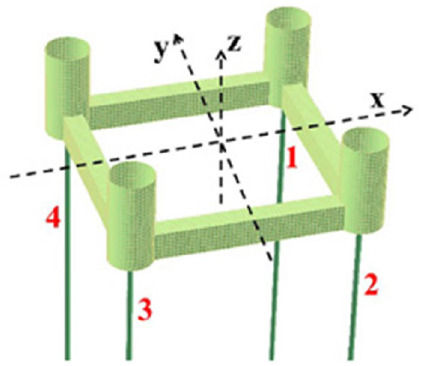
Figure 1. Configuration of TLP and tendons 33 . Distance between each pair of neighbouring tendons is 76 m. Each column radius 12.5